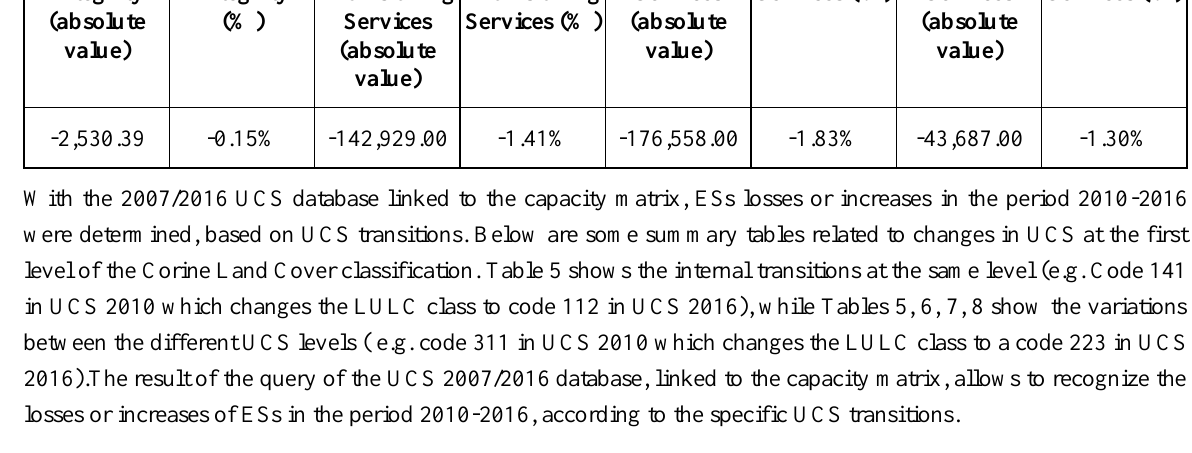
Table 4. Contribution of different type of landscape systems to the provision of ecosystem services (support, provisioning, regulating, cultural). ∆ Ecological